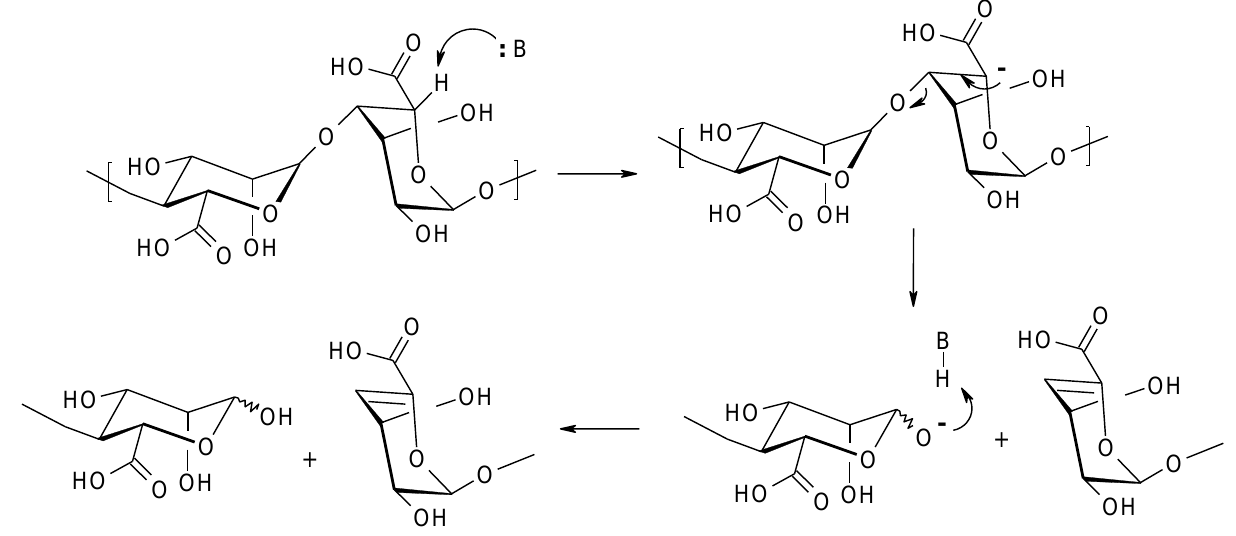
Figure 5. Base catalyzed degradation of alginate (β-elimination).